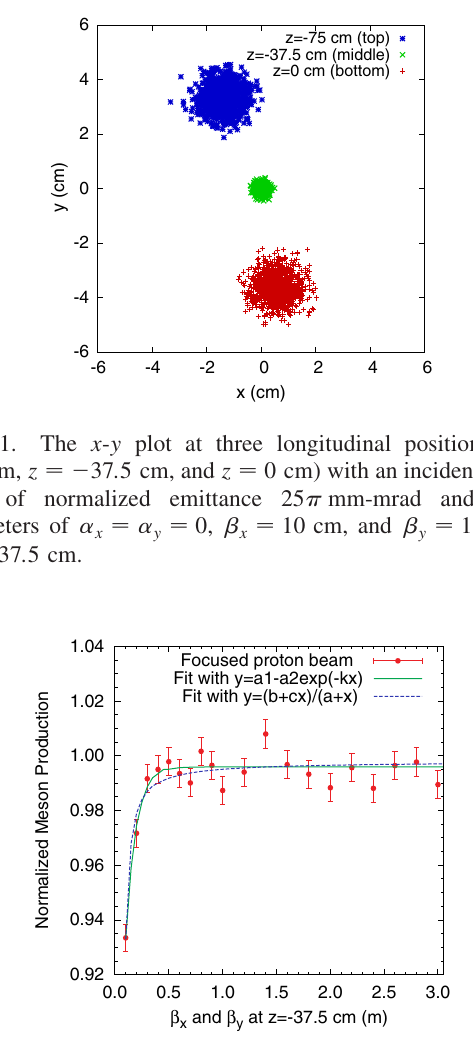
FIG. 12. Meson productions with a Gaussian proton beam, as a function of (cid:1) x and (cid:1) y at z ¼ (cid:2) 37 : 5 cm . (cid:1) x is always set equal to (cid:1) y for these